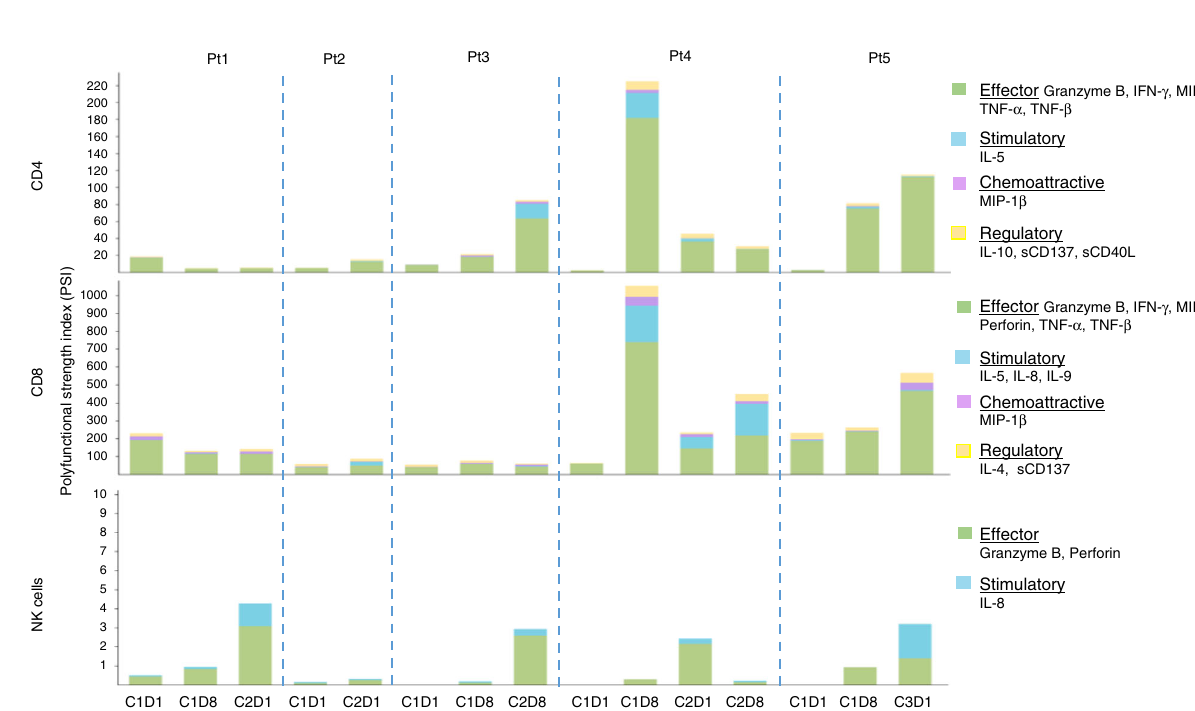
Fig. 5 NKTR-214 elicits a marked upregulation of immune gene expression and T cell polyfunctionality. a Heatmap representing hierarchical clustering of the most variable genes (~1500 genes) in the ACT + NKTR-214 and ACT + IL-2 treated group ( n = 3/group). b Gene set enrichment analysis of log2 fold- change of ACT + NKTR-214 and ACT + IL-2 samples, representing the top-10 biological pathways with signi fi cant gene induction. NES: normalized enrichment score; FDR: false discovery rate. c Bar charts of select T cell genes. Mean± s.e.m ( n = 3), ** p < 0.01, *** p < 0.001, **** p < 0.0001, ns = not signi fi cant, unpaired t -test. d – f Single cell measure of polyfunctionality and polyfunctional strength of adoptively transferred T cells from spleen and tumors (pool of 3 each/group). d Schematic of the single cell IsoCode chip to analyze T cell polyfunctionality. e Single-cell polyfunctionality (left) and polyfunctional strength index (PSI) (right) graphs. Polyfuctionality: co-secretion of 2 + cytokines per cell; PSI: percentage of polyfunctional cells in the sample, multiplied by the intensities of the secreted cytokines. S: spleen. T: tumor. f Single-cell polyfunctional heat map illustrates the single-cell cytokine combinations being secreted by each sample. Each column corresponds to a speci fi c cytokine or combination of cytokines, and the orange squares represent the frequency at which the group was secreted by the corresponding sample. The cytokine groups are ordered by overall frequency across all the samples.